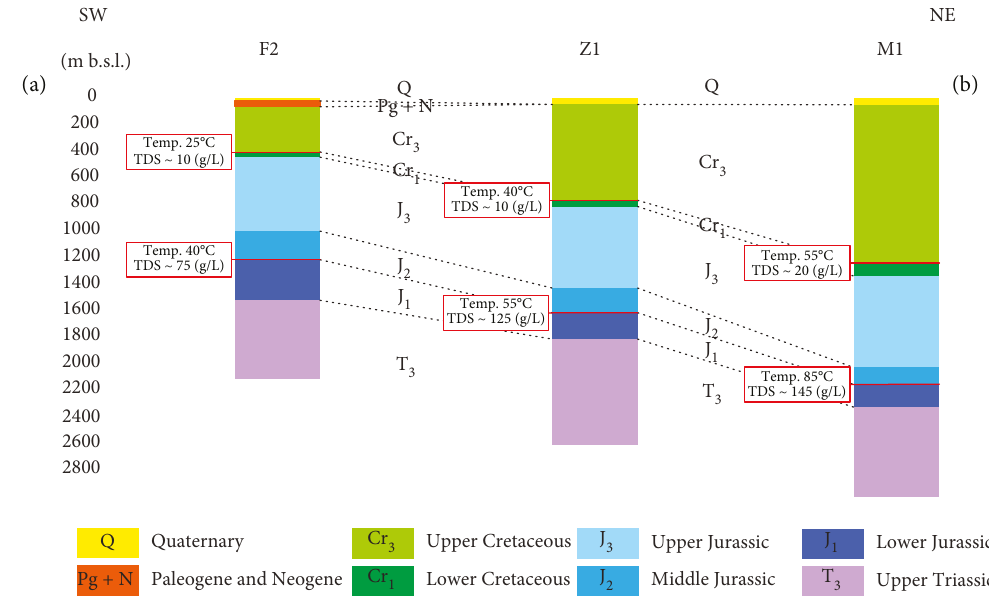
Figure 2: Geological correlation of deep boreholes in the research area (along the green dotted line in Figure